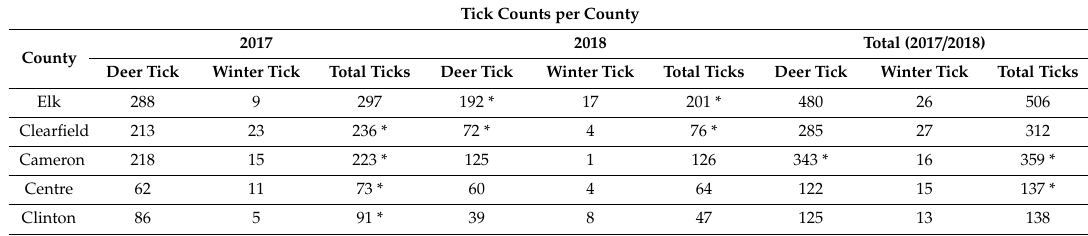
Table 1. Total number of ticks collected from elk per county, Pennsylvania USA. Tick counts are based on the county in which elk were harvested. Data is organized by year, tick species, and county. A one-way ANOVA statistical analysis was performed to determine if there were di ff erences between tick load per elk per county. A post hoc Tukey HSD analysis found di ff erences represented by an asterisk in the table. An asterisk next to tick counts from 2017 and 2017 / 2018 indicate a di ff erence to Elk county and an asterisk next to tick counts from 2018 indicate a di ff erence to Cameron county. No location data was available for one elk. One deer tick collected from this elk was not included in the